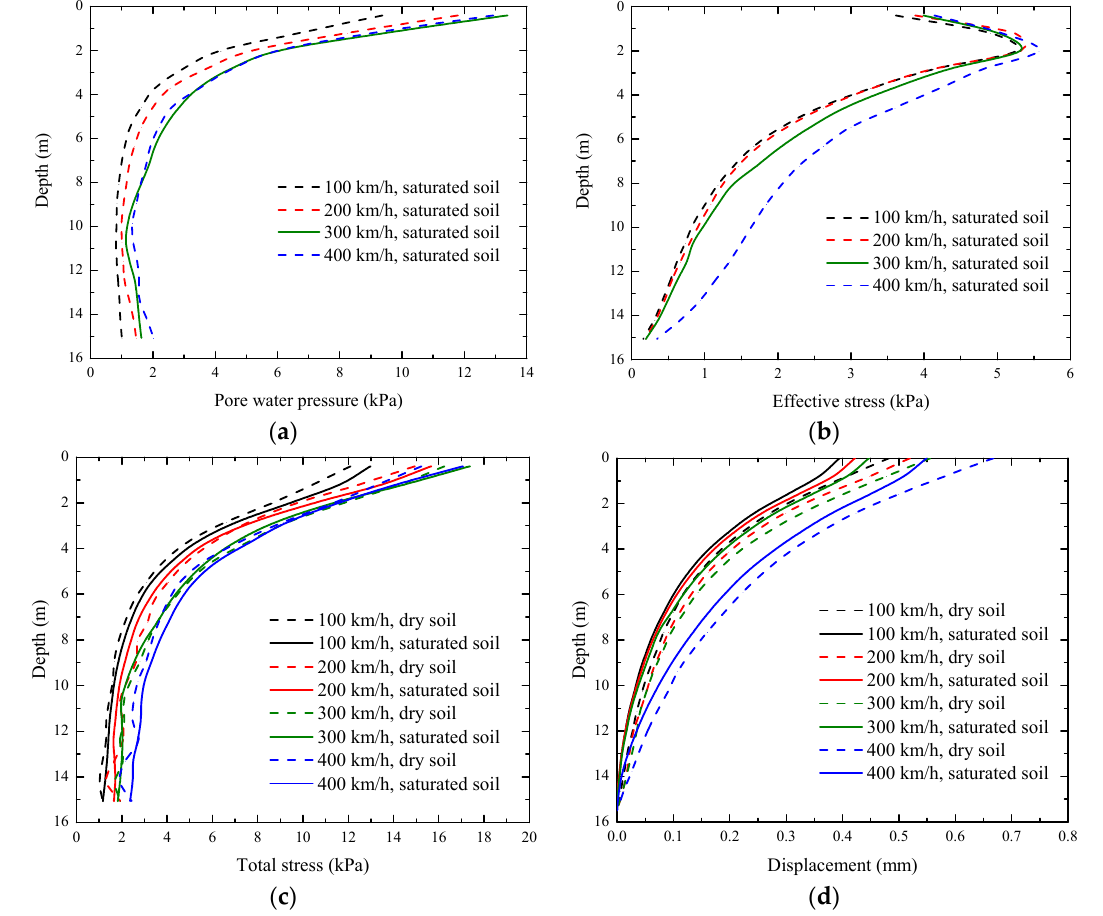
Figure 9. Vibration responses with depth: ( a ) Pore water pressure, ( b ) effective stress, ( c ) total stress, and ( d ) displacement.